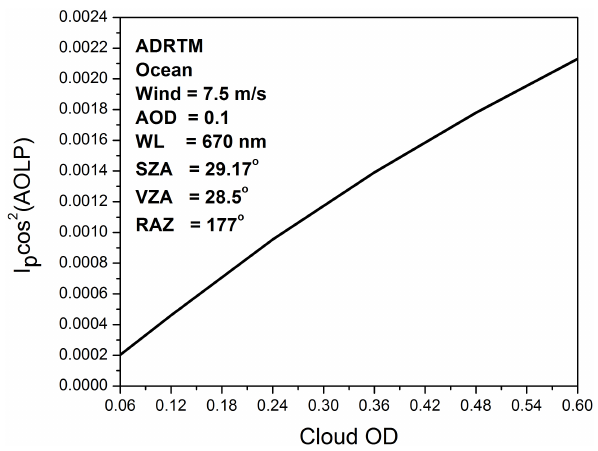
Figure 8. Modeled p-polarized reflectance at a wavelength of 670 nm as a function of cloud optical depth (OD), at a viewing zenith an- gle (VZA) of 28.5 ◦ , and a relative azimuth angle (RAZ) of 177 ◦ for super-thin cirrus clouds over oceans. The solar zenith angle (SZA) is 29.17 ◦ , the wind speed is 7.5ms − 1 , and the aerosol optical depth (AOD) is 0.1. The size distribution of the ice particles in the cirrus clouds is from Heymsfield and Platt (1984) for the cloud temper- ature of − 20 to − 25 ◦ C. The mid-latitude cirrus clouds are com- posed of a mixture of complex particle shapes as described in Baum et al. (2000). This figure shows the nearly linearly relationship be- tween cloud OD and AOLP for OD<0.6.